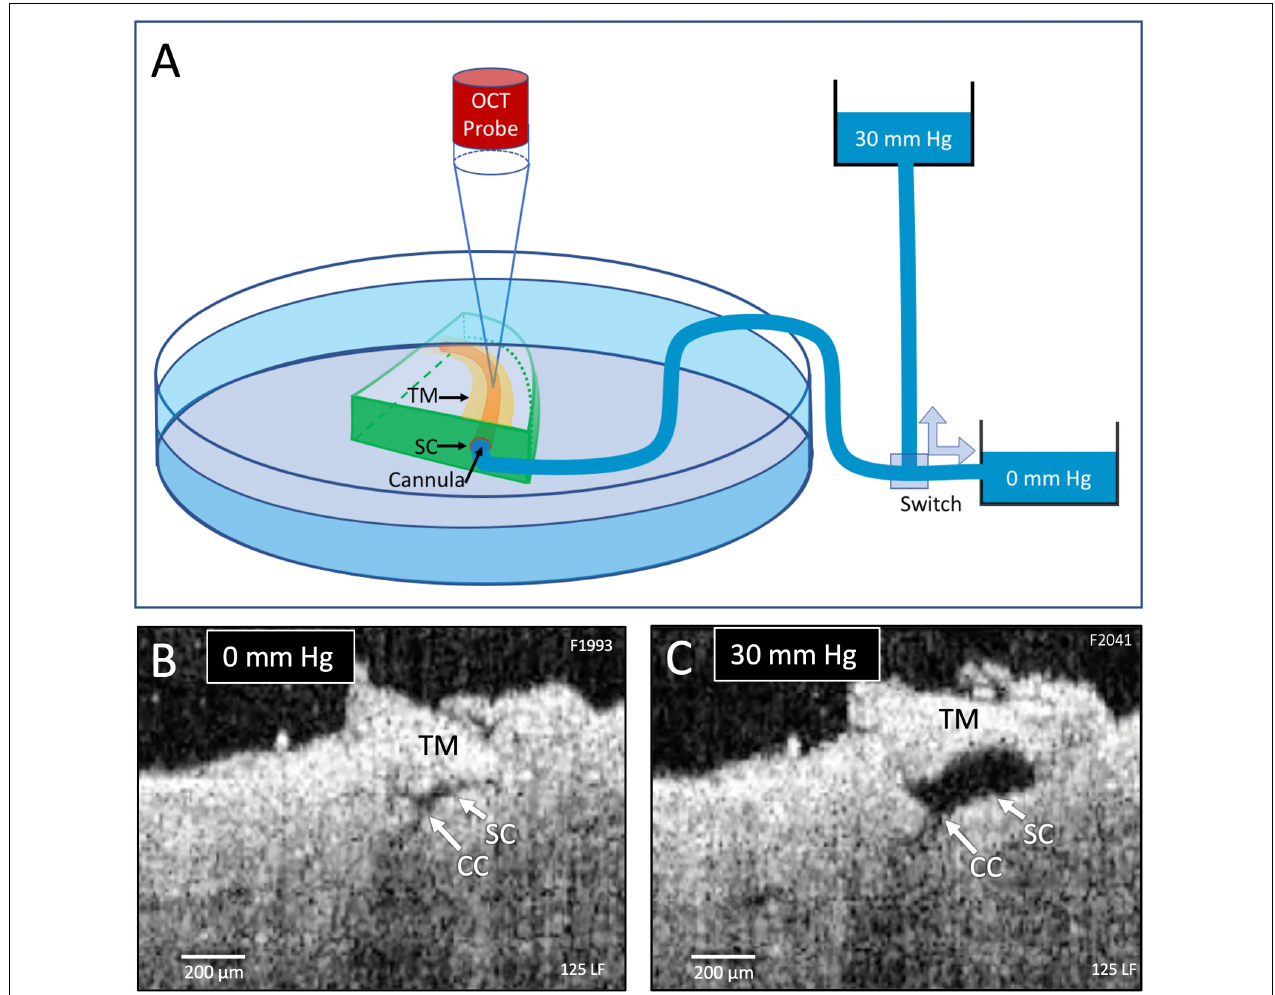
FIGURE 1 | Experimental setup and real-time pressure-dependent optical coherence tomography (OCT) images. (A) A tissue wedge in a Petri dish with the trabecular meshwork (TM) facing upward during high-resolution OCT imaging. A micromanipulator guides one end of a cannula to the wedge and holds it securely in Schlemm’s canal (SC). The opposite end of the cannula leads to a valve that switches between two reservoirs, one at 0 mm Hg and the other at 30 mm Hg. OCT imaging is initiated before switching reservoirs and continues until achieving a new steady-state tissue configuration. (B,C) OCT images at 0 and 30 mm Hg, respectively, from the distal SC location, are noted in Figure 2 . Both SC and collector channels (CC) collapse at 0 mm Hg but markedly enlarge when pressure increases in